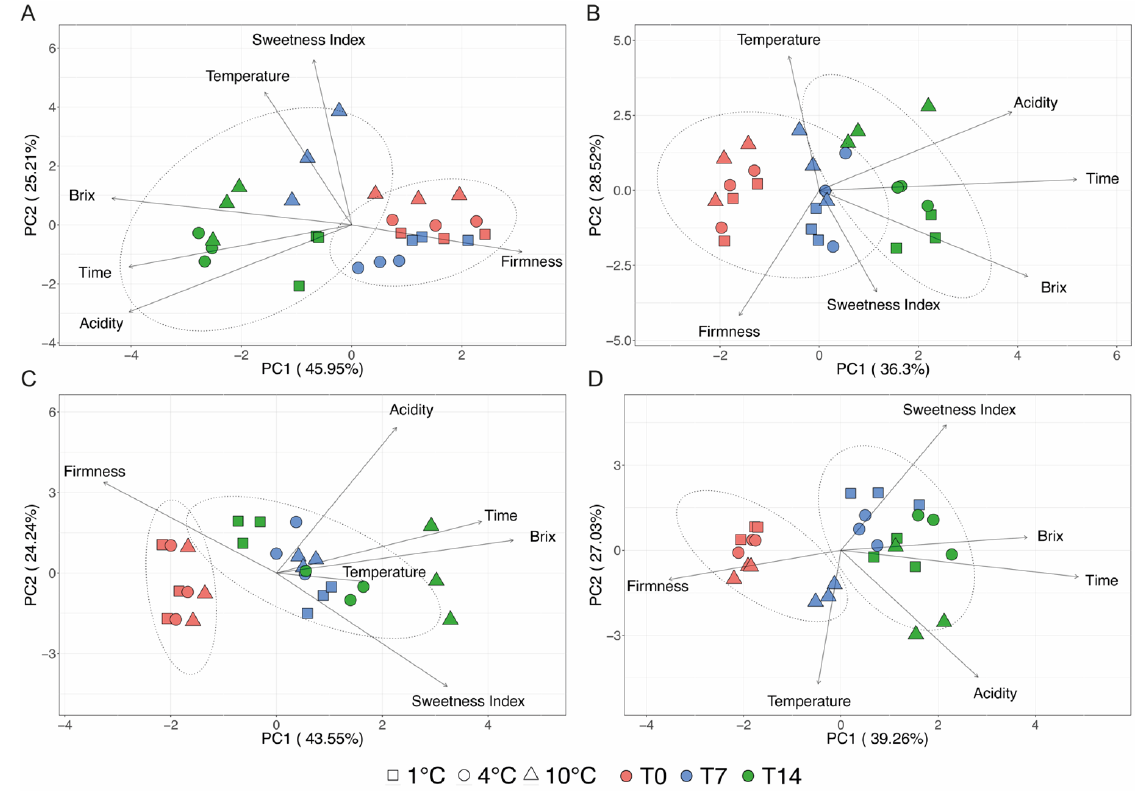
Figure 1. Principal component analyses of post-harvest quality data. ( A ) Scatterplot representing the distribution of control strawberry samples as affected by the storage temperature (1, 4 and 10 °C) and the storage period (0, 7 and 14 days). ( B ) Scatterplot representing the distribution of 50 mg L − 1 Si-treated strawberry samples as affected by the storage temperature (1, 4 and 10 °C) and the storage period (0, 7 and 14 days). ( C ) Scatterplot representing the distribution of 100 mg L − 1 Si-treated strawberry samples as affected by the storage temperature (1, 4 and 10 °C) and the storage period (0, 7 and 14 days). ( D ) Scatterplot representing the distribution of 200 mg L − 1 Si-treated strawberry samples as affected by the storage temperature (1, 4 and 10 °C) and the storage period (0, 7 and 14 days).